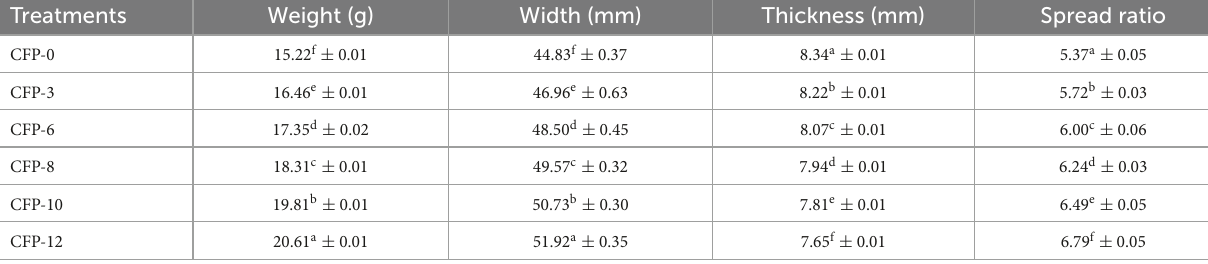
TABLE 5 Physical properties of cookies fortified with pomegranate peel (PP) powder.